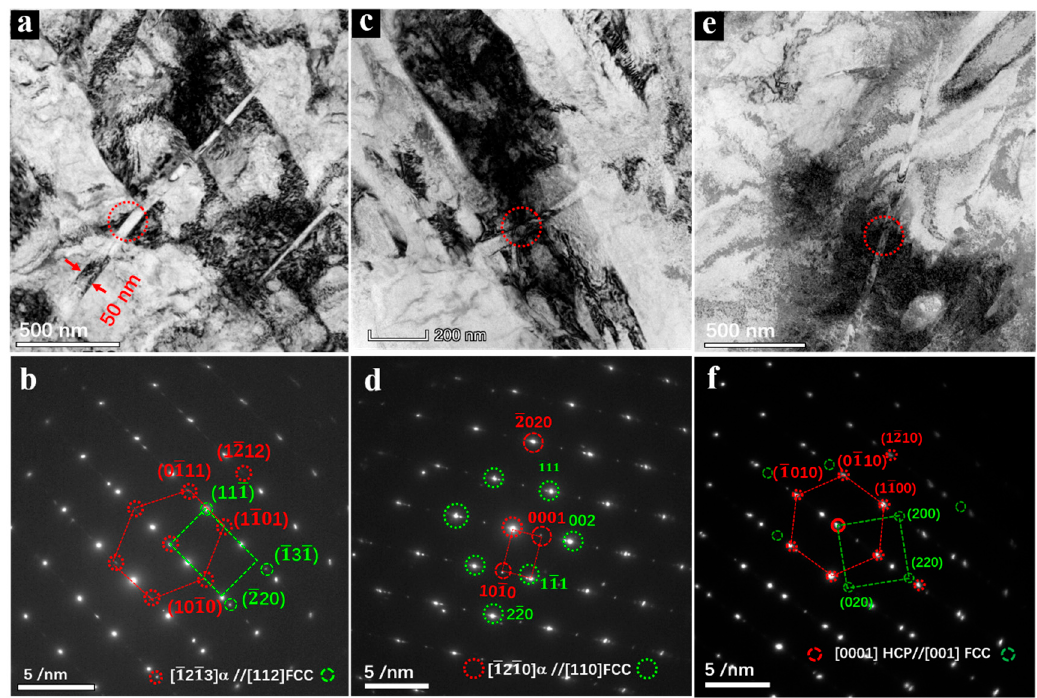
Figure 2. ( a , c , e ) TEM pictures and ( b , d , f ) SAED patterns of the FCC-Ti lath structure and matrix, three determination positions of SAED were remarked by circles in TEM pictures, respectively.